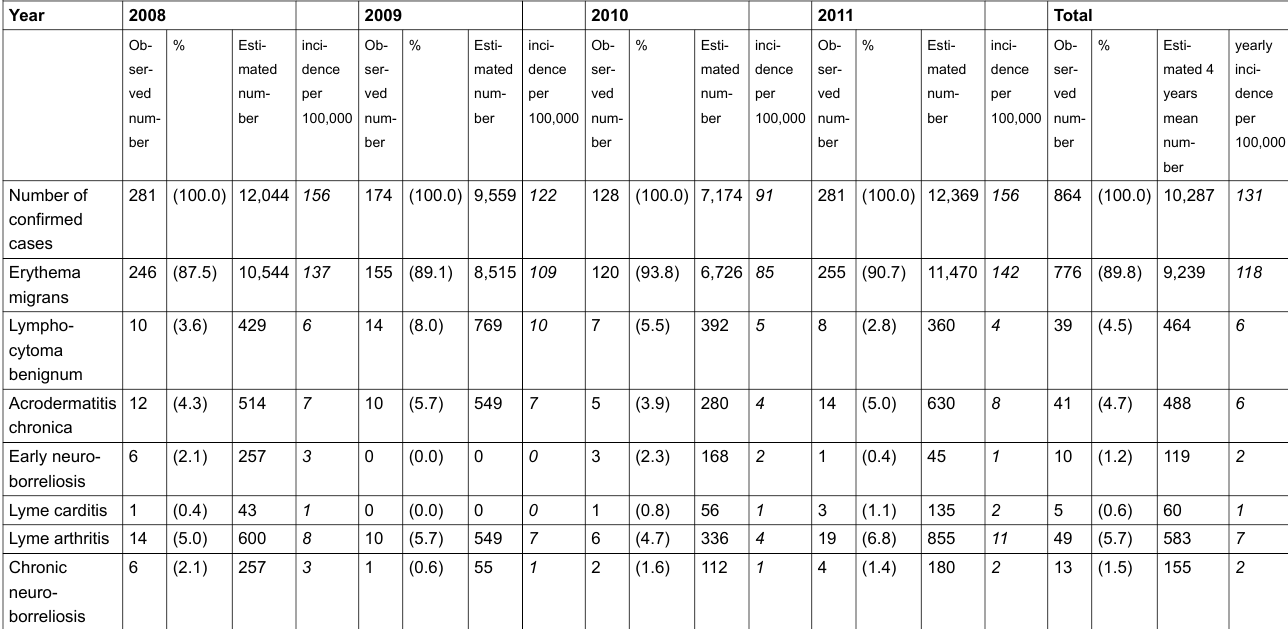
Table 4: Clinical symptoms of Lyme Borreliosis in Switzerland, 2008 to